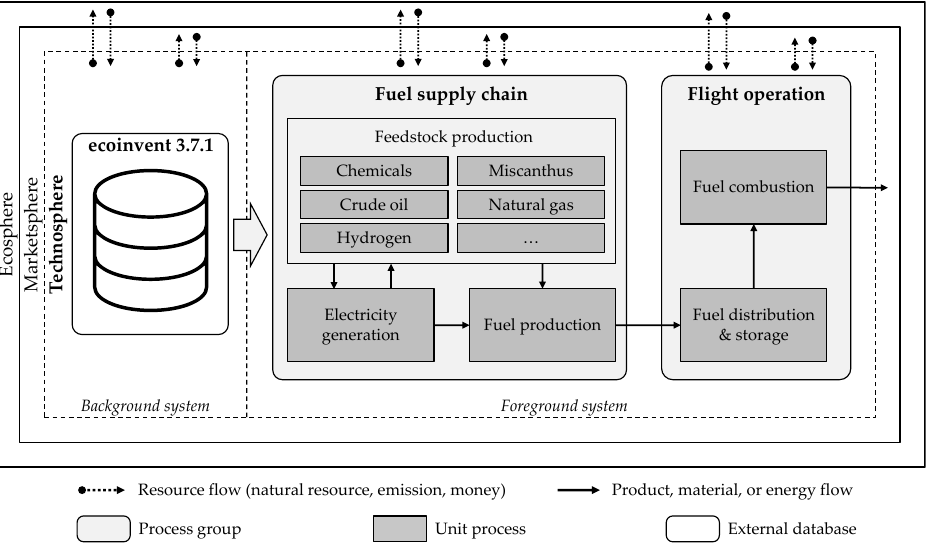
Figure 3. Foreground and background system within the system boundaries, including exchanges between the technosphere, ecosphere, and marketsphere.